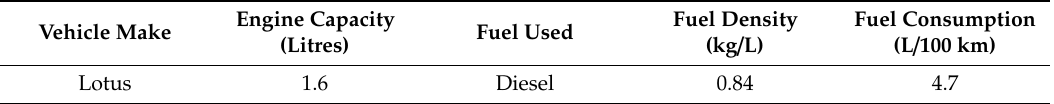
Table 1. Vehicle Base